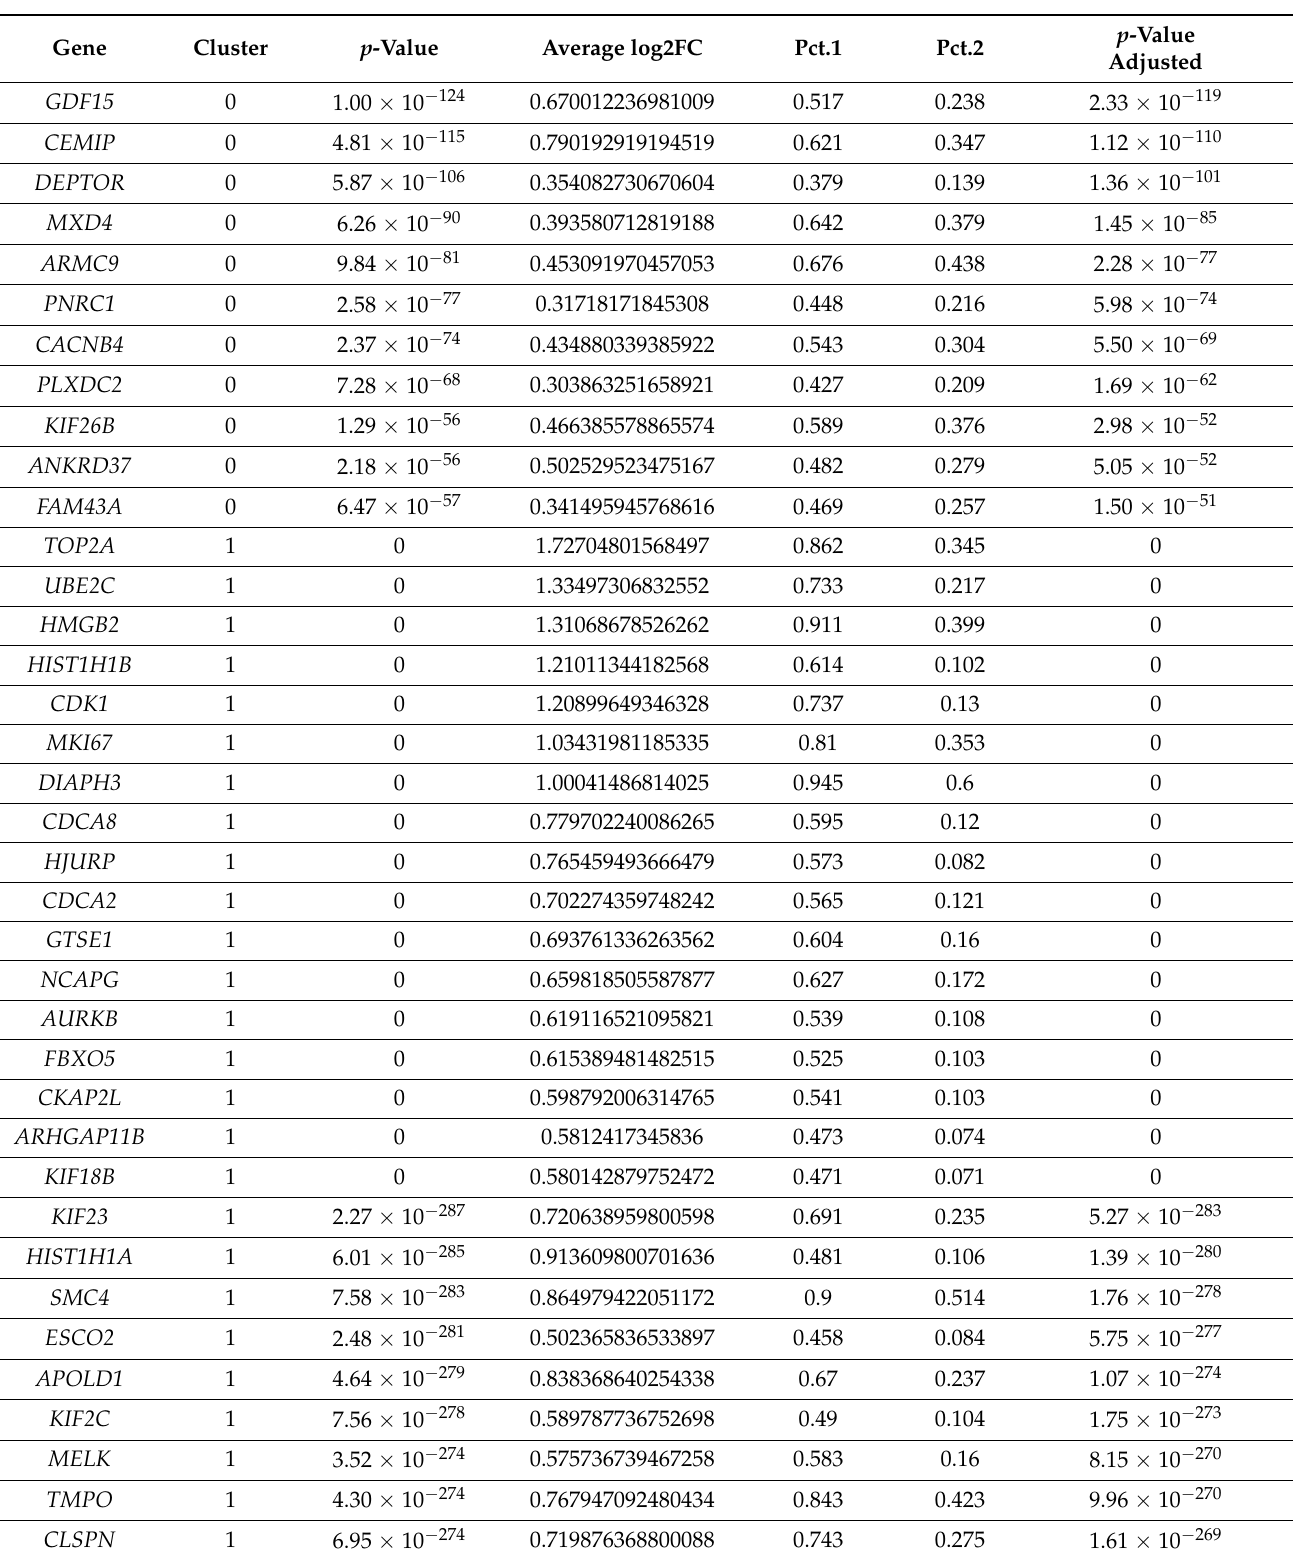
Table 4. Highly variable genes after cell cycle regression in CAFs isolated from